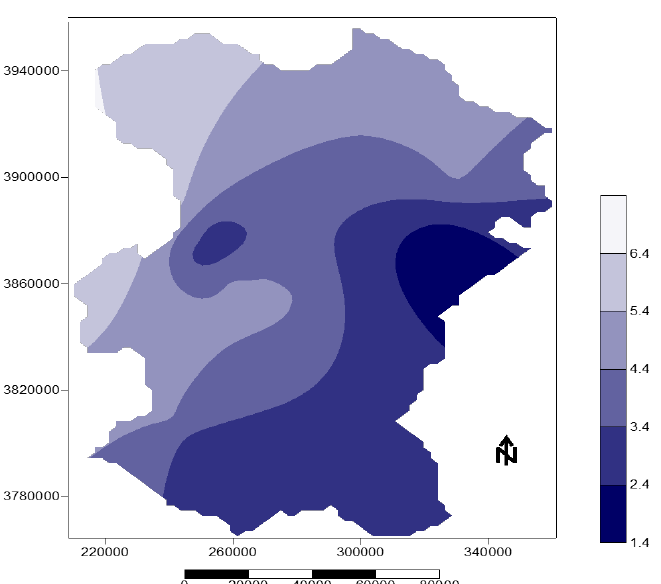
*Effective coefficient of gravelius coefficient: 1.5